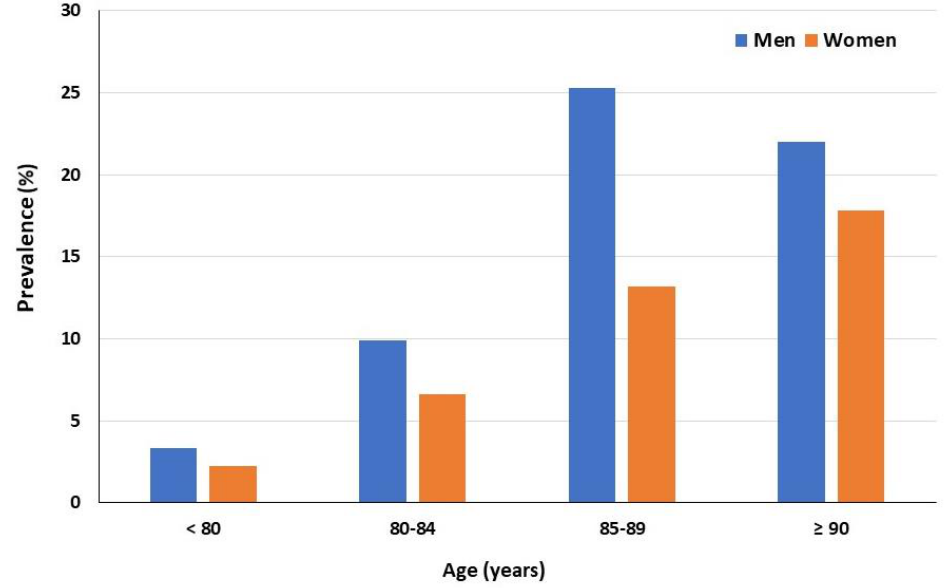
Figure 2. Cardiac amyloidosis prevalence according to age and sex.